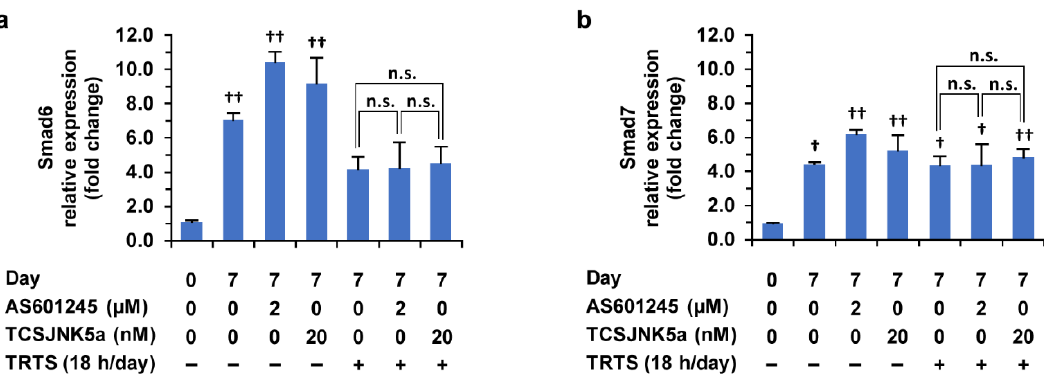
Figure 11. Effects of TRTS in the presence or absence of AS601245/TCSJNK5a on gene expressions in PC12-P1F1 cells. ( a , b ) PC12-P1F1 cells were incubated with AS601245 (2.0 µ M) or TCSJNK5a (20.0 nM) for 7 days. In addition, PC12-P1F1 cells were also treated with TRTS for 18 h per day for 7 days in the presence of AS601245 (2.0 µ M) or TCSJNK5a (20.0 nM). The target mRNA expression was normalized to that of the internal control β -actin. For each indicated gene, results are presented as fold changes relative to day 0 control: Smad6 ( a ), Smad7 ( b ). The data represent the means ± standard deviation of three replicates. † p < 0.05 vs. day 0 control; †† p < 0.01 vs. day 0 control; n.s., not significant.